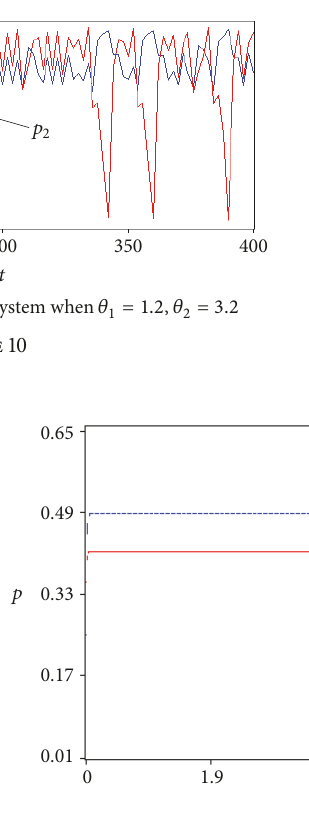
Figure 12: Bifurcation diagram of 𝑝 with respect to 𝜃 1 when 𝜃 2 = 1.2